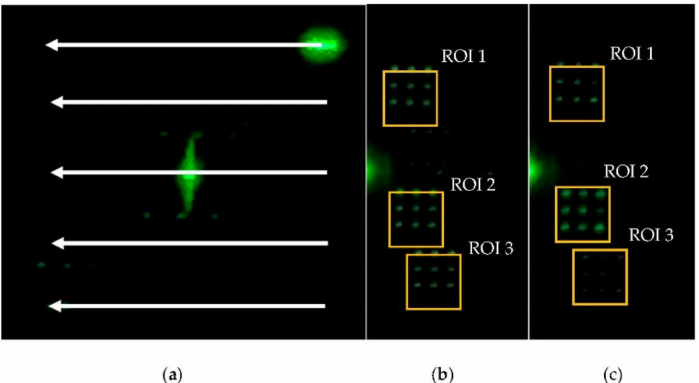
Figure 6. ( a ) Single ROI scan with single-beam steering. See Video S1. ( b ) Multiple ROIs scan with the same beam weights. See Video S2. ( c ) Multiple-ROI scan with different beam weights (ROI 2 > ROI 1 > ROI 3). See Video